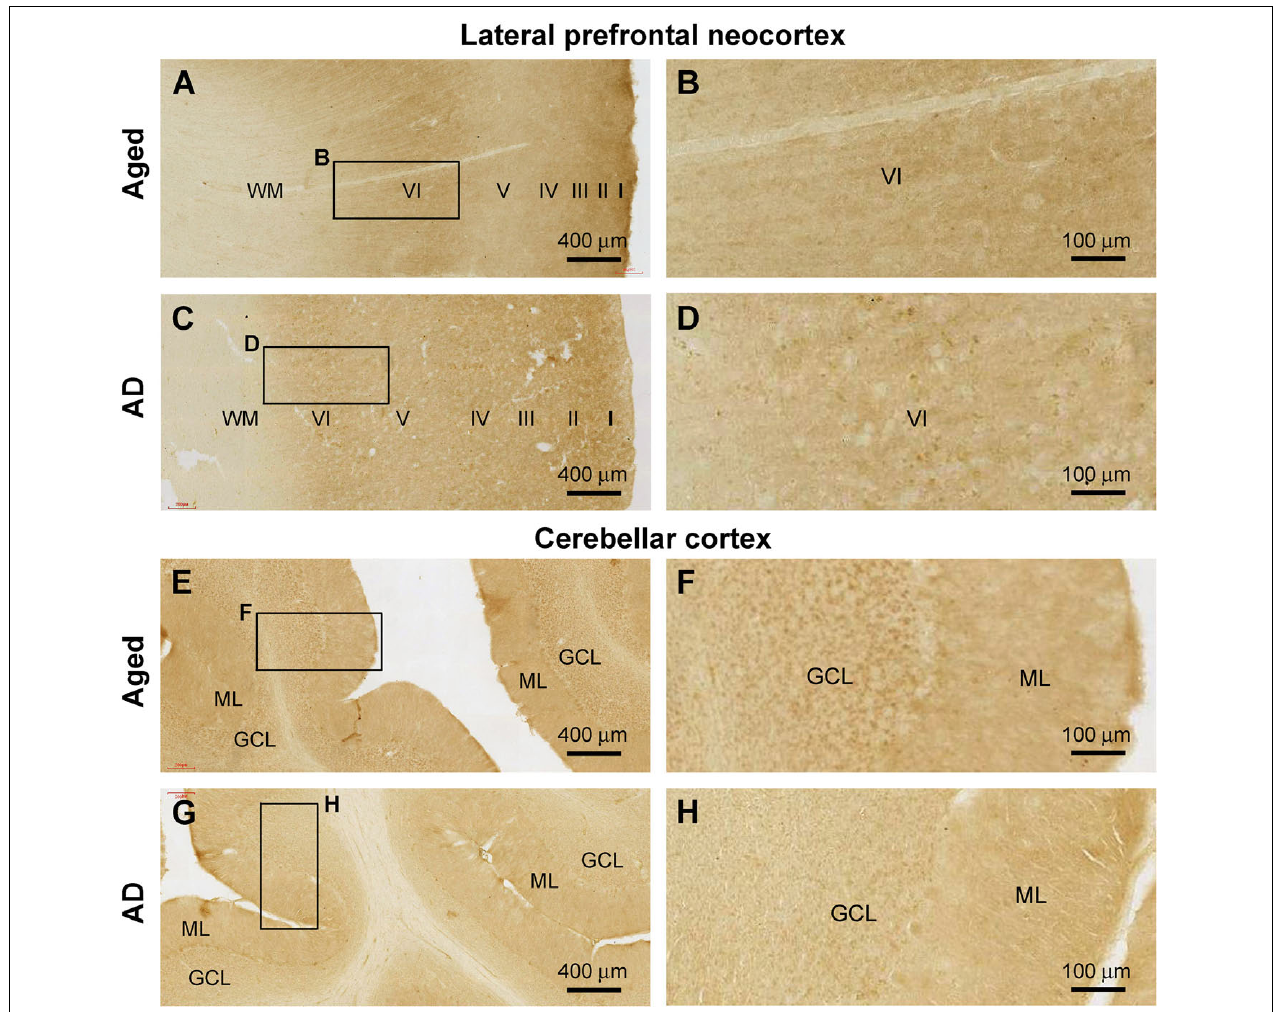
FIGURE 11 | Representative images illustrating altered Shank3 IR in the frontal neocortex and cerebellar cortex in the aged (case# 15 in Table 1 ) and Alzheimer’s disease (AD, case# 26 in Table 1 ) human brains. (A,B) illustrate preservation of the laminar pattern of Shank3 IR in the neuropil but loss of labeled neuronal somata in the aged brain relative to that seen in the adult (in reference to Figures 1E–H ). Panels (C,D) show a diminishment of the differential laminar distribution of IR in the neuropil in the AD brain (compare with A,B and also Figures 1E–H ). Panels (E–H) show a trend of decrease of Shank3 in the cerebellar granule cell layer (GCL) in the aged and AD brains, also in reference to the relative intensities of IR over the molecular layer (ML) and GCL seen in adult cases ( Figures 7A,B ). Scale bars are as